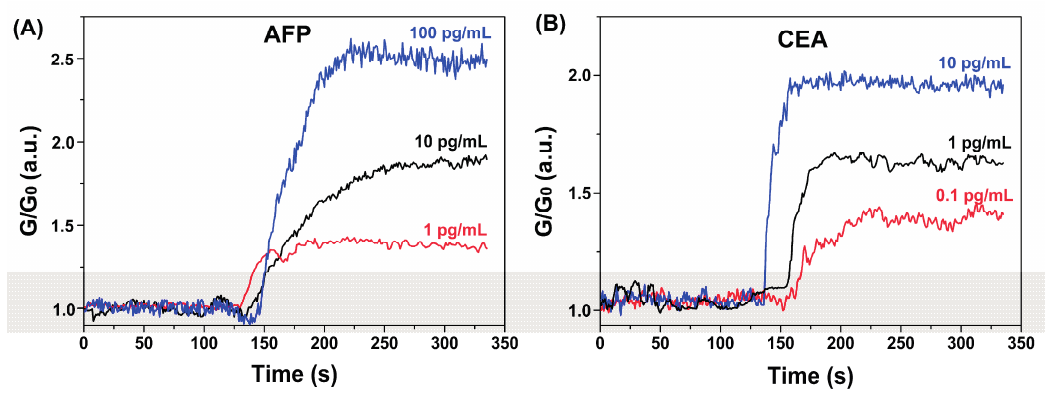
Figure 6. Real-time biosensing behaviors of the fabricated biosensor. Normalized